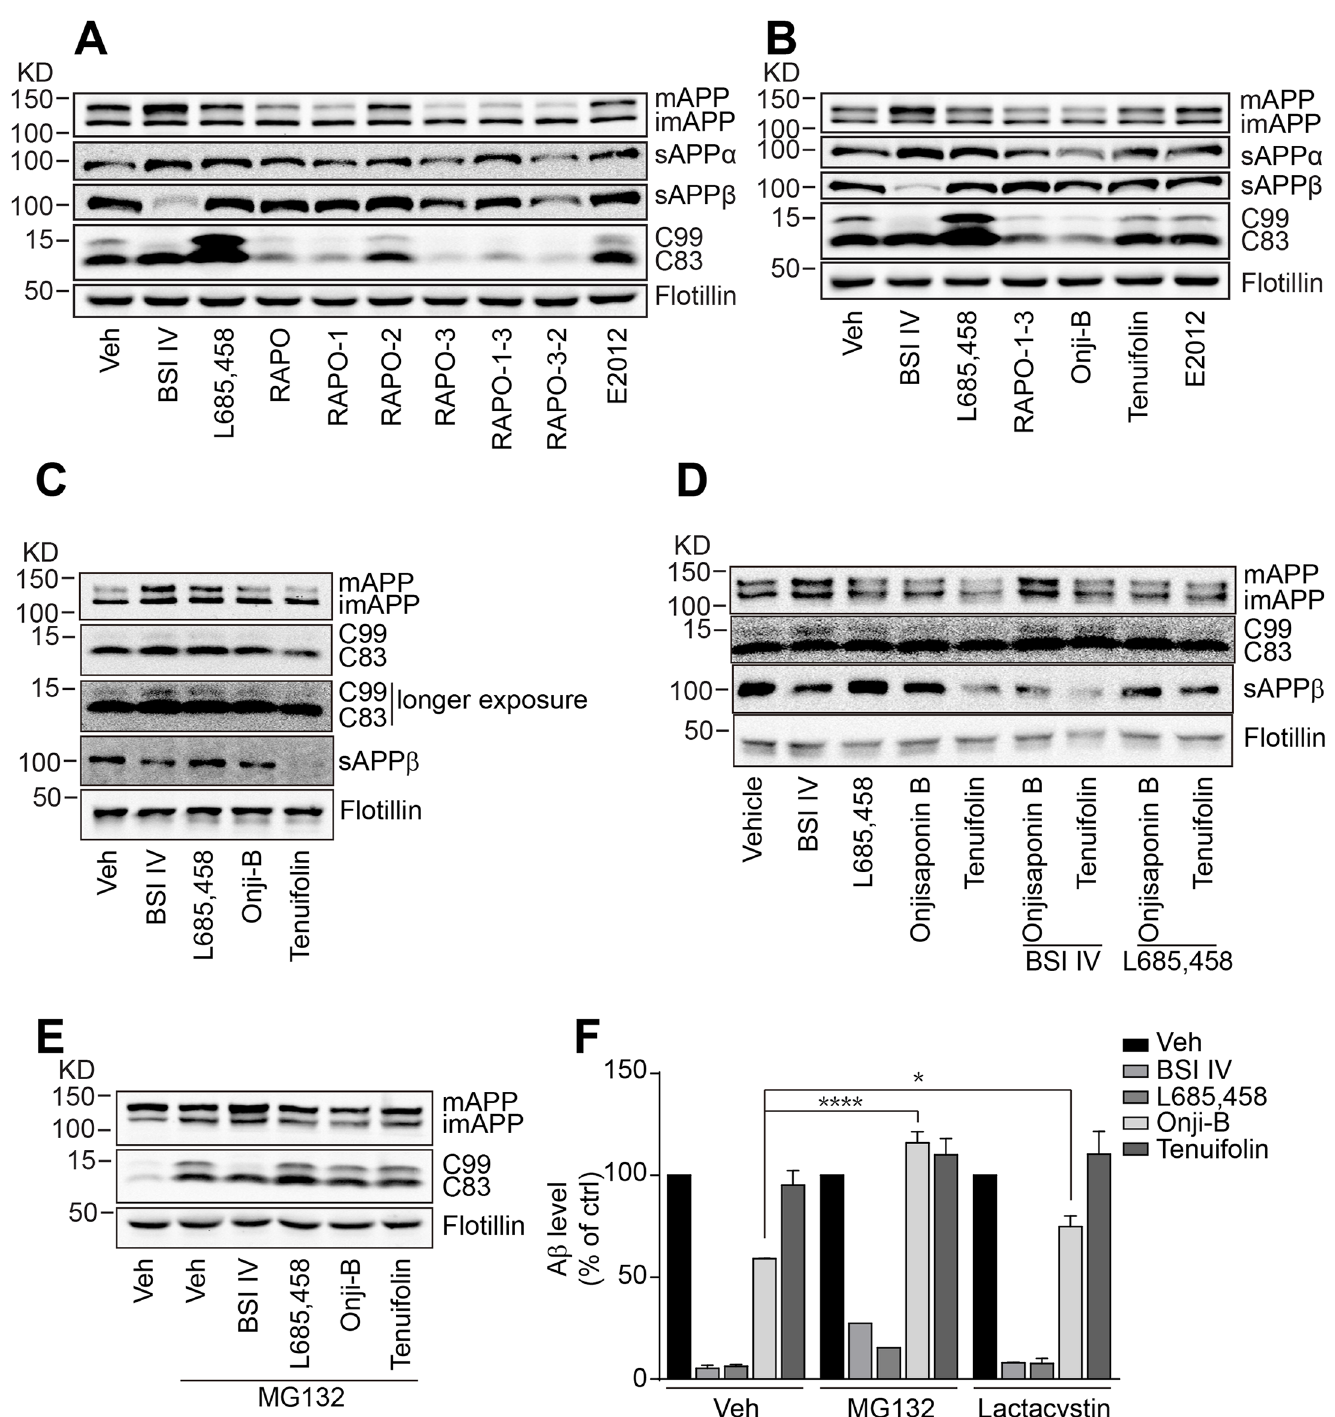
Fig 3. Onjisaponin B promotes APP degradation. (A-B) RAPO, RAPO fractions (1 mg/ml) (A) and Onjisaponin B (10 μ M) (B) reduce mature APP levels in HEK293-APPswe cells. (C) Generation of sAPP β in the presence of 10 μ M Onjisaponin B or Tenuifolin in BACE1-assay buffer. (D) Mature APP was accumulated in detergent-soluble membrane fractions treated with 10 μ M BSI IV together with Onjisaponin B. (E-F) The proteasome inhibitor MG132 (10 μ M) prevents the reduction of mature APP (E) and A β generation (F) by Onjisaponin B. (F) The proteasome inhibitor lactacystin (20 μ M) partially blocks the A β reduction by Onjisaponin B. Data are presented as the mean ± s.e.m. * p < 0.05, ** p < 0.01 and *** p < 0.001. Two-way ANOVA with Bonferroni's multiple comparison test (F).